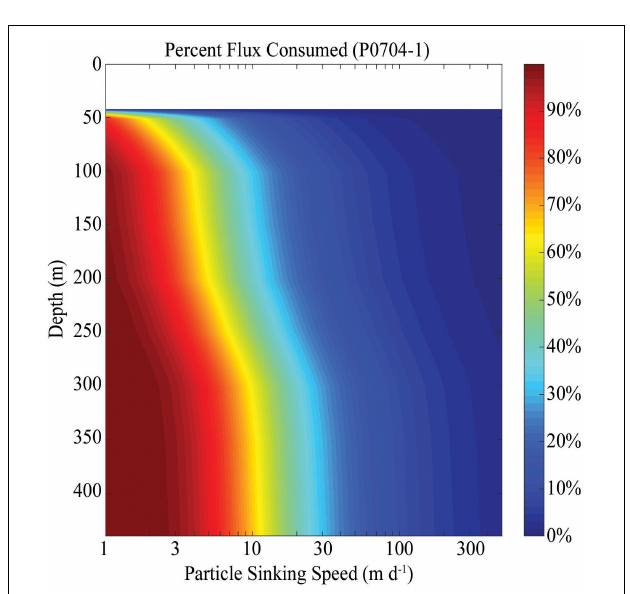
FIGURE 5 | Cumulative percent carbon flux consumed by suspension feeders by a certain depth for particles with different sinking speeds ( x -axis). Data is for P0704 Cycle